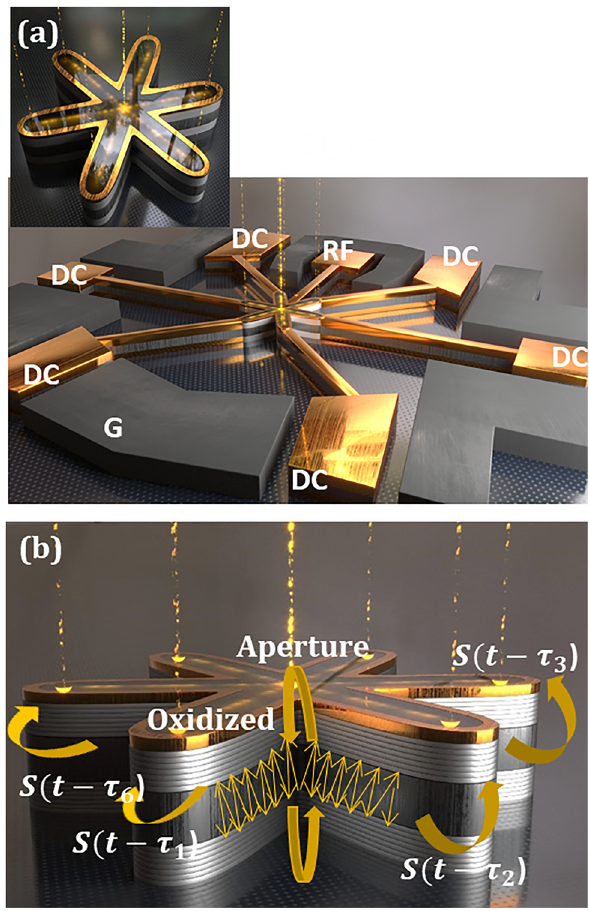
Figure 1: Schematic structure of our hexagonal transverse-coupled cavityvertical-cavitysurface-emittinglasers(VCSEL)(a)topviewand (b) cross-sectional view